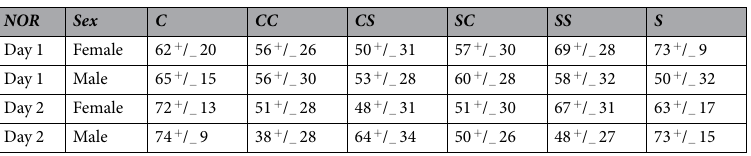
Table 3. Novel object recognition % attending novel object, mean and standard